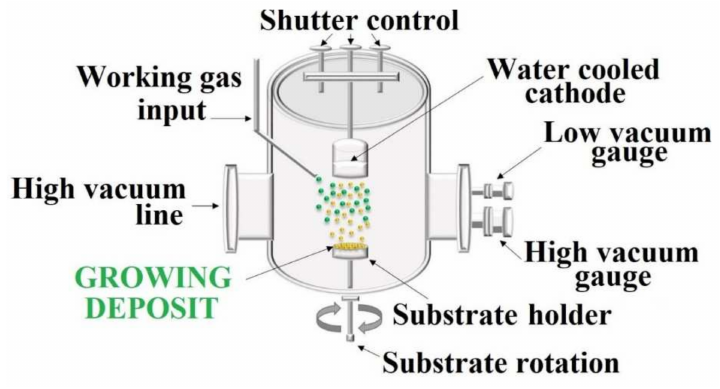
Figure 9. Inside mechanisms of magnetron sputtering